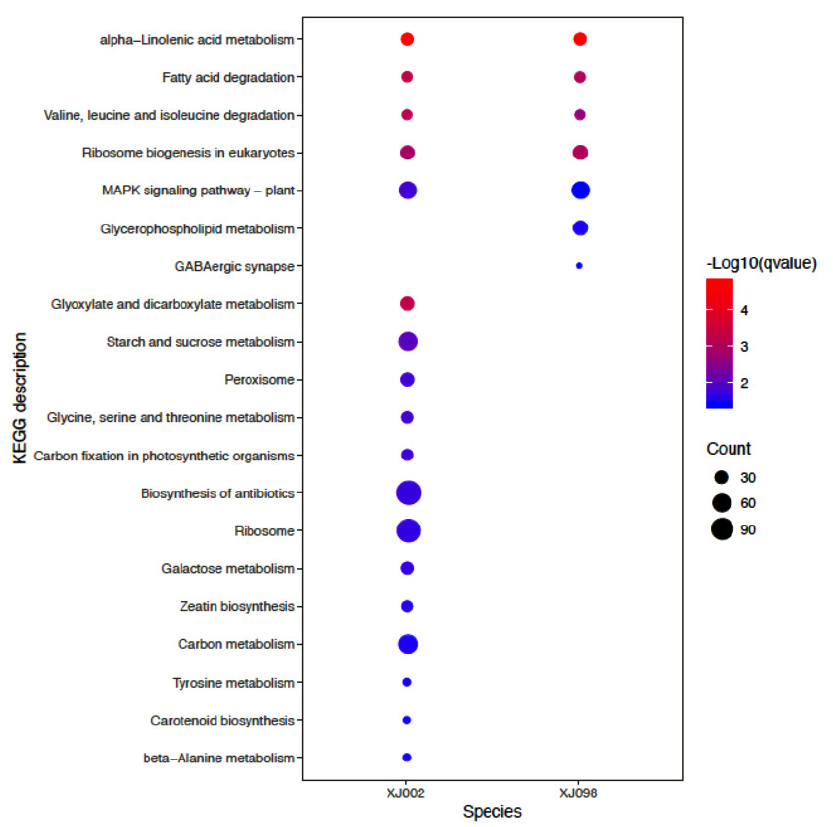
Figure 6. KEGG pathways prominently enriched DEGs in the XJ002 and XJ098 under control and drought stress.